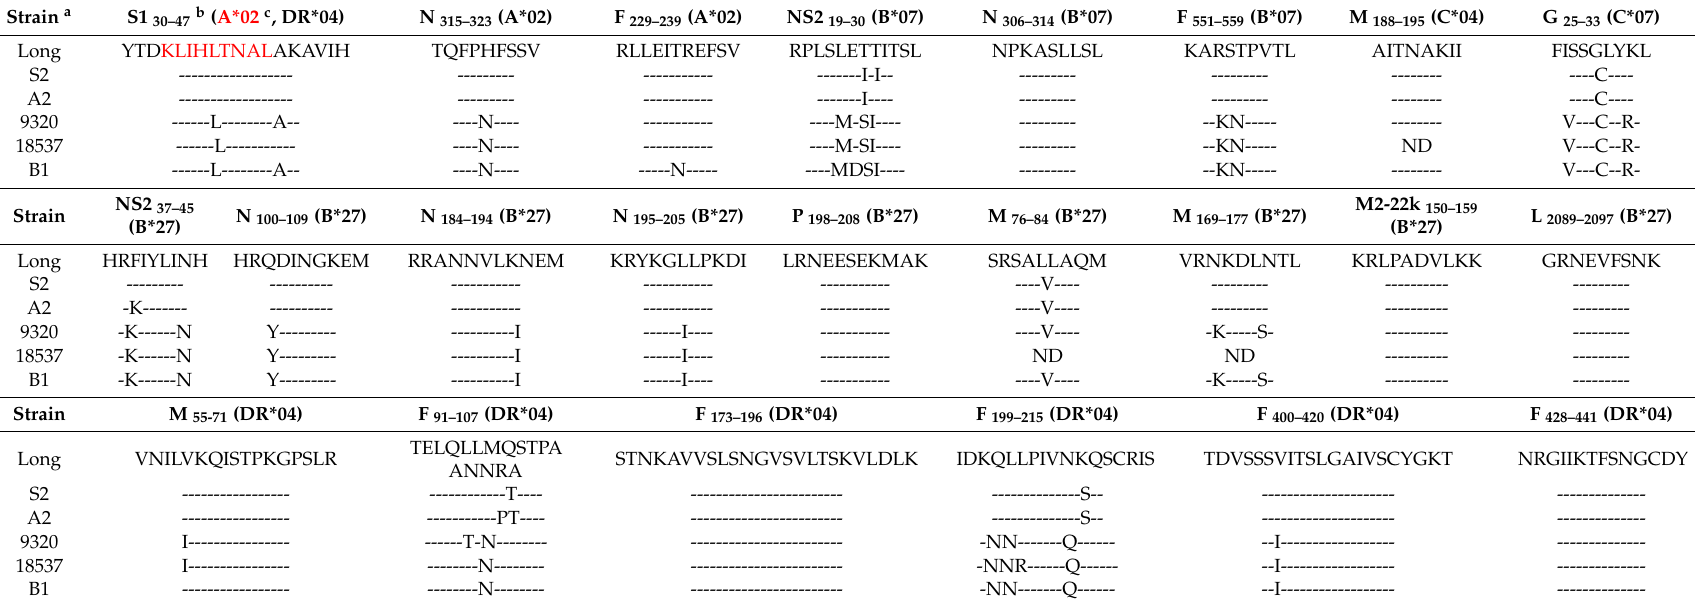
Table 4. Conservation of HLA viral ligands in several HRSV